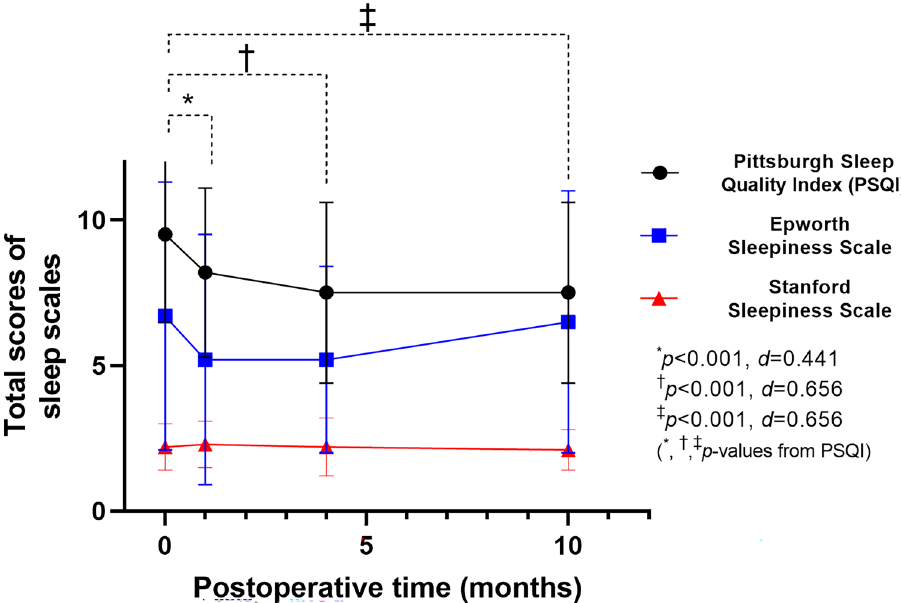
Figure 1. Repeated measures of sleep parameters before and after thyroidectomy with a 10-month follow-up. Error bars indicate ± standard deviations of the mean. d indicates Cohen’s